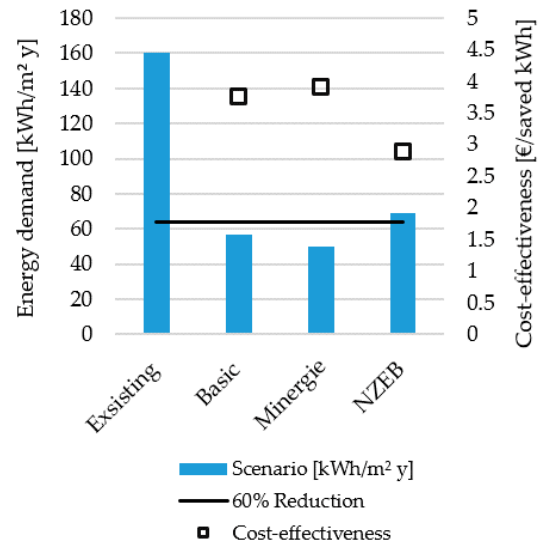
Figure 8. Results of primary energy demand for existing state and applied global renovation packages. Global cost-effectiveness values (right y-axis) and target limit for the renovation (horizontal line).